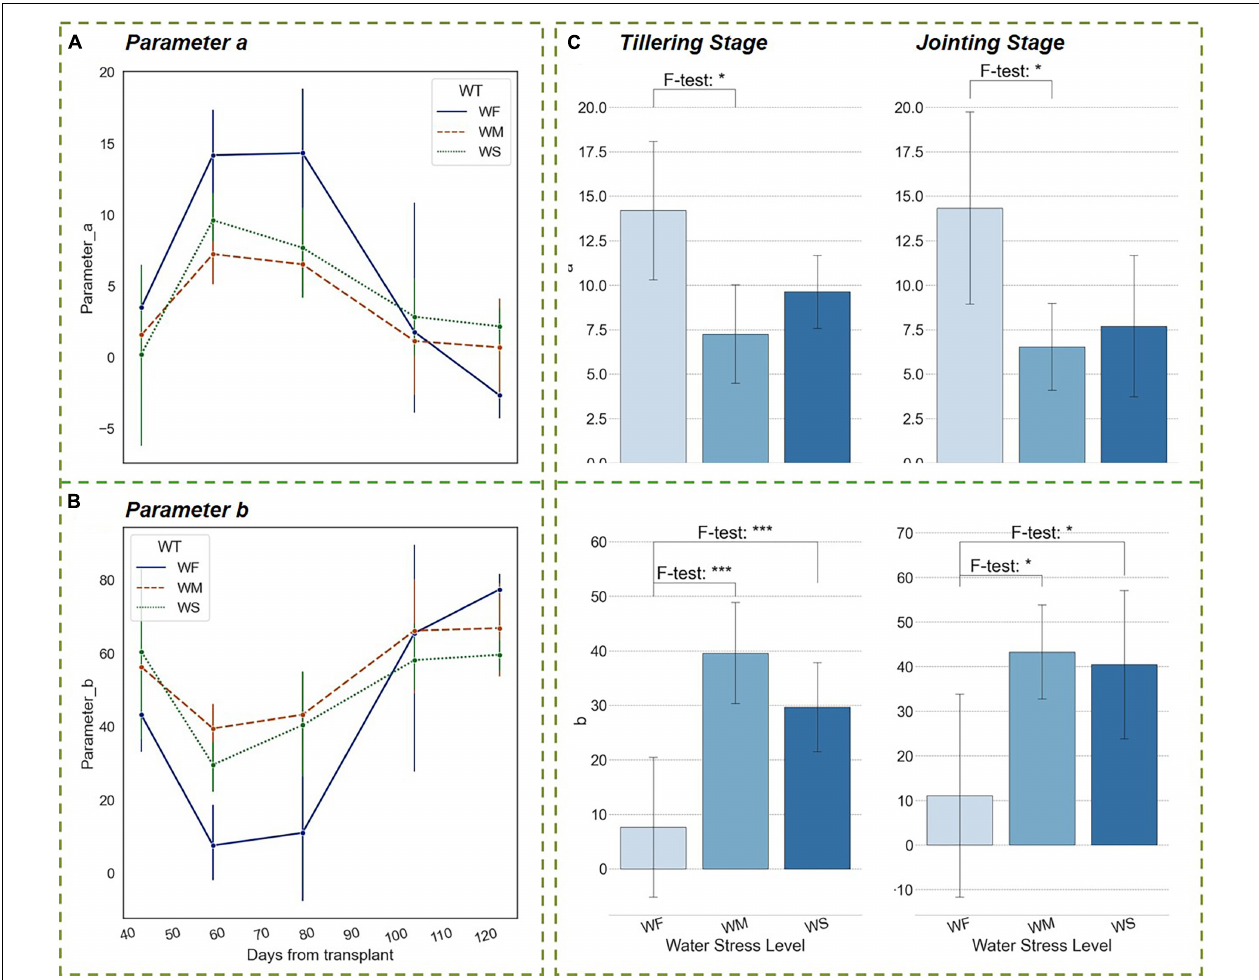
FIGURE 7 | Trends of parameters of the vertical distribution function in different water treatment groups during the whole growth period. (A) Parameter a , (B) Parameter b . (C) Significant differences in parameters among three water treatment groups at the tillering and jointing stages. The blue bars indicate the value of parameter a or b. The number of asterisk (*) represents the degree of the significance ( p -value of < 0.05 *, p -value of < 0.01 **, and p -value of < 0.001